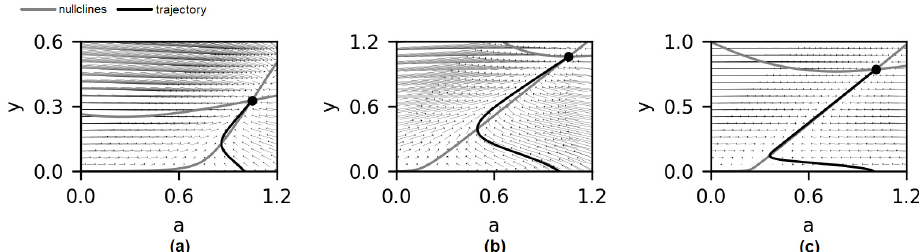
Figure 3. Phase planes for the models, presented in Figure 2. The models were fitted to experimental data of platelet aggregation in response to ADP at 2.5 μ M ( a ), 5 μ M ( b ), or 10 μ M ( c ). Nullclines are given in grey, trajectories from point { a,y } = {1,0} into steady state (same as in Figure 2) are given in black. Steady state parameters (the asterisk(*) denotes the stationary values of the variables): ( a ) a * = 1.047, y * = 0.327, λ 1 = − 0.24, λ 2 = − 0.041; ( b ) a * = 1.06, y * = 1.06, λ 1 = − 0.17, λ 2 = − 0.028; ( c ) a *= 1.012, y *= 0.78, λ 1 = − 0.68, λ 2 = − 0.014.